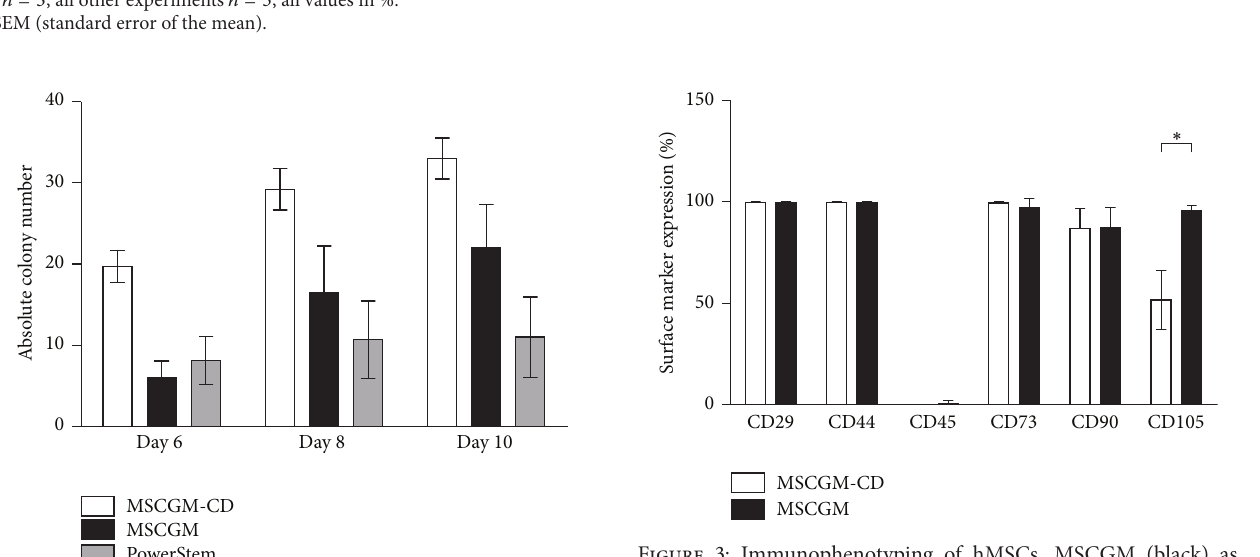
Figure 3: Immunophenotyping of hMSCs. MSCGM (black) as well as MSCGM-CD (white) treated cells were negative for CD45, but positive for CD29, CD90, CD44, CD73, and CD105. CD105 expression in MSCGM is significantly higher than in MSCGM- CD cultivated cells. Data presented as mean ± SEM (for CD29 expression by hMSCs grown in MSCGM 𝑛 = 3 , all other experiments 𝑛 = 5 ). Unpaired two-tailed 𝑡 -test was performed for statistical analysis. ∗ 𝑃 ≤ 0.05